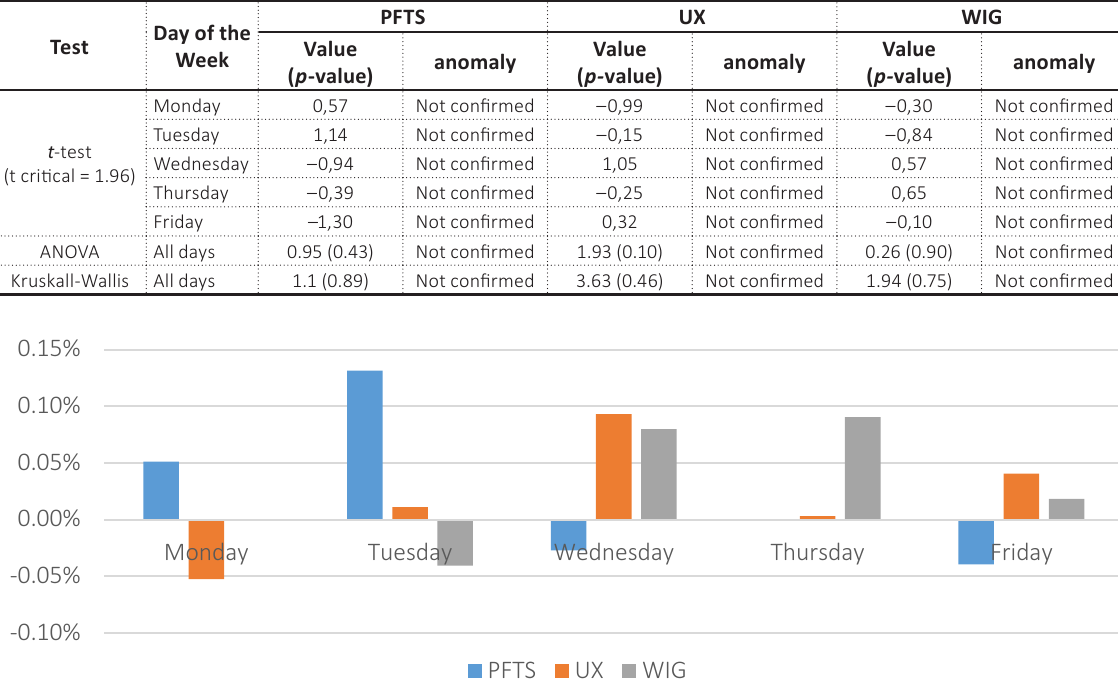
Table 7. Results of yield difference tests for different days of the